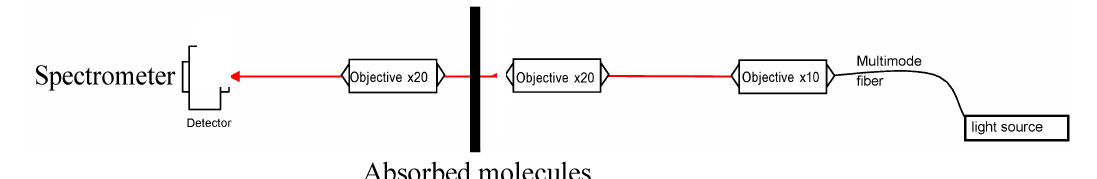
Figure 3. Optical set-up for LSPR extinction measurements.